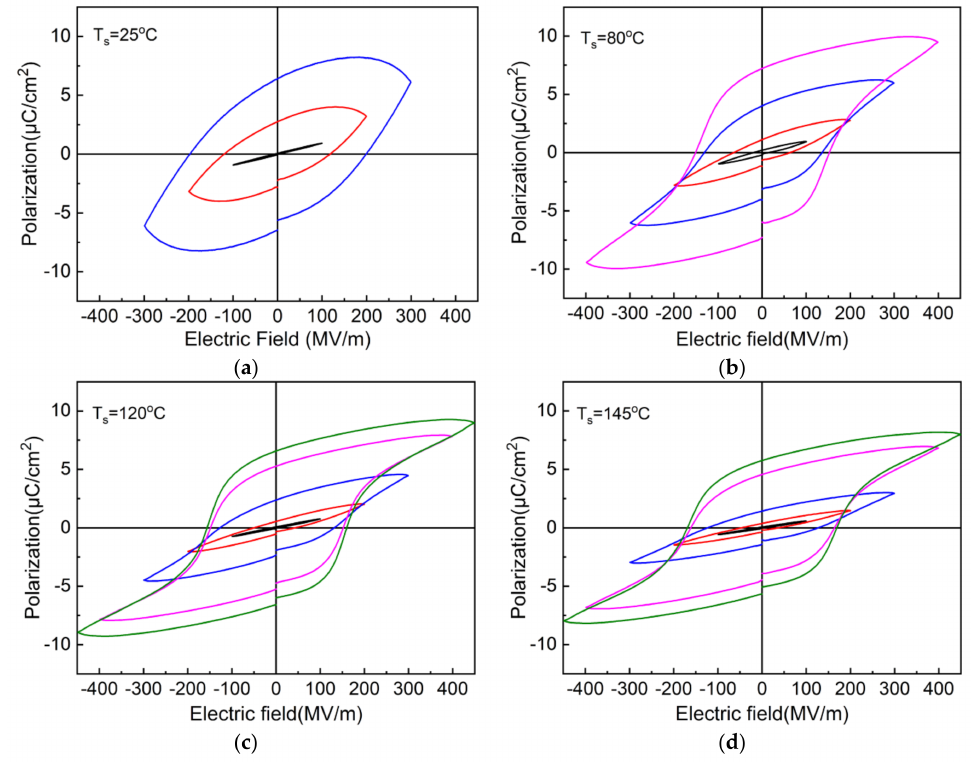
Figure 8. D - E hysteresis loops of the stretched nylon-11 films with stretching temperatures of ( a ) 25 ◦ C, ( b ) 80 ◦ C, ( c ) 120 ◦ C and ( d ) 145 ◦ C. The stretching ratio is set as